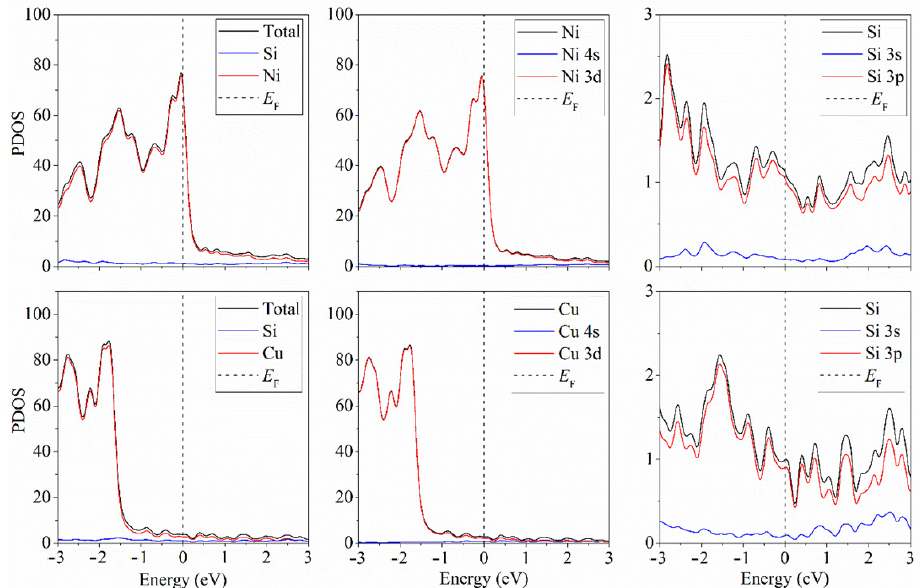
Figure 3. Partial density of states of the “silicene–four-layer nickel substrate” and “silicene–four-layer copper substrate” systems.